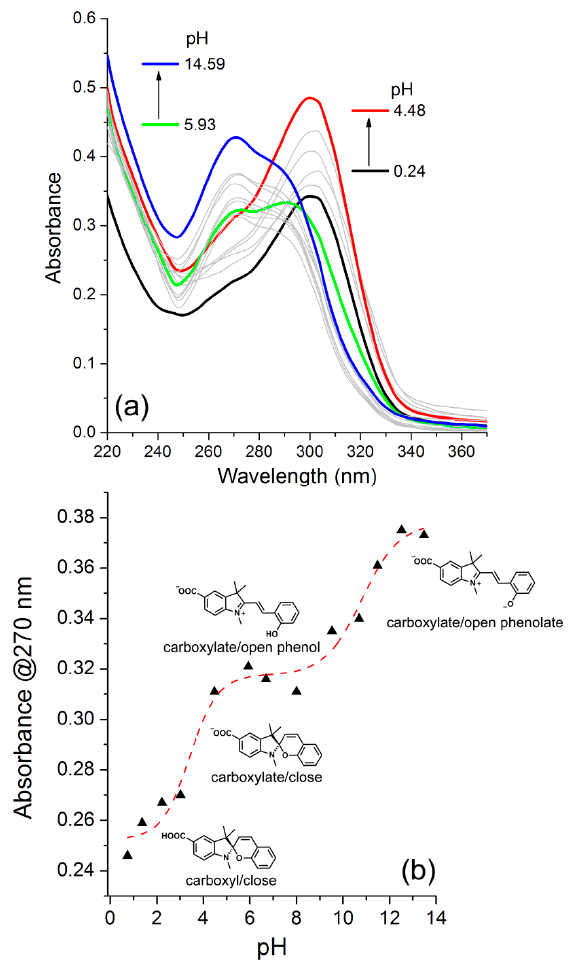
Figure 5. ( a ) UV-Vis absorption spectra of spiropyran in ethanol / water solution (1:1 v / v ) in indicated pH Figure 5. (a) UV-Vis absorption spectra of spiropyran in ethanol/water solution (1:1 v/v) in indicated values at 25 ◦ C and ( b ) dependence on the absorbance intensity vs. pH recorded at 270 nm. The dotted pH values at 25 °C and (b) dependence on the absorbance intensity vs. pH recorded at 270 nm. The line was fitted according to the Boltzmann sigmoidal curve dotted line was fitted according to the Boltzmann sigmoidal curve function.